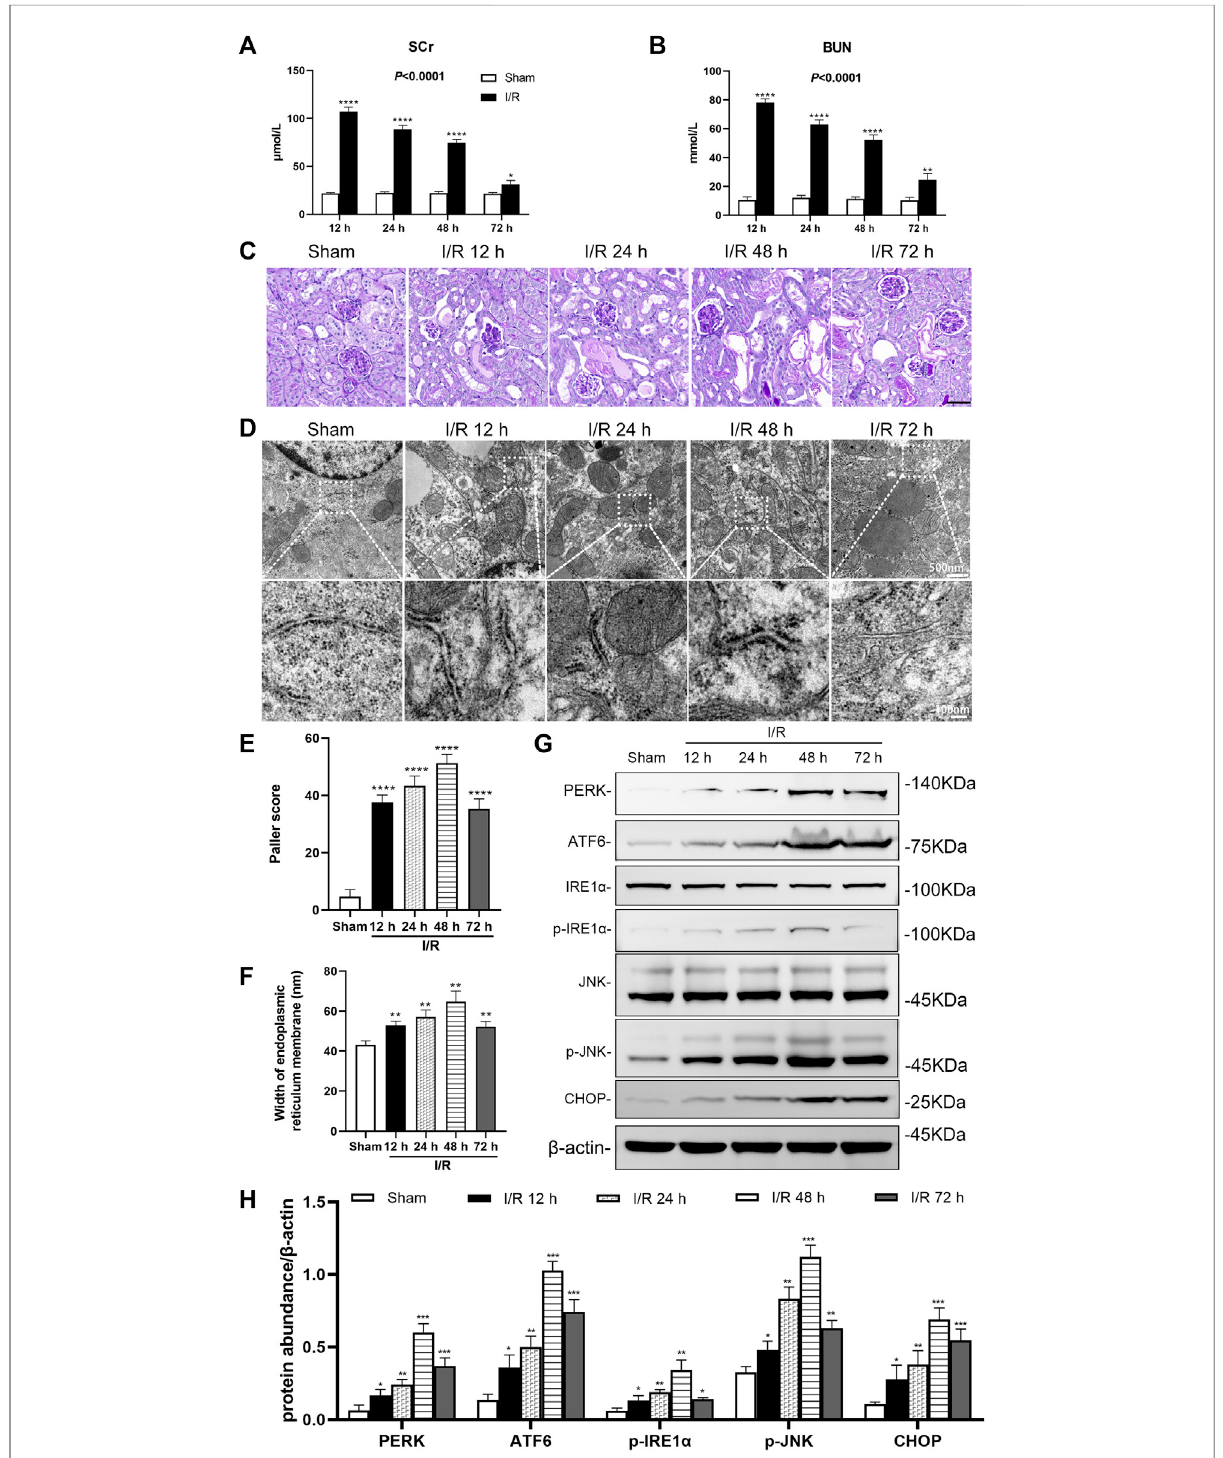
FIGURE 1 Renal artery ischemia-reperfusion leads to renal insuf fi ciency and ER stress in renal tubules of mice. Male C57BL/6J mice underwent sham operation or bilateral renal artery clamping for 27 min before reperfusion (A) Changesin serum creatinine(Scr). When the ischemia-reperfusion (I/R) groups were compared at 12, 24, 48, and 72 h after I/R, the expression was highest at 12 h ( p < 0.0001) (B) Changes in blood urea nitrogen (BUN). When the I/R groups were compared at 12, 24, 48, and 72 h after I/R, the expression was highest at 12 h ( p < 0.001) (C) PAS staining showed lesionsinrenaltubulartissue.Scalebar=100 μ m (D) TransmissionelectronmicroscopywasusedtoobservetheERofmicerenaltubulesafterI/R (E)